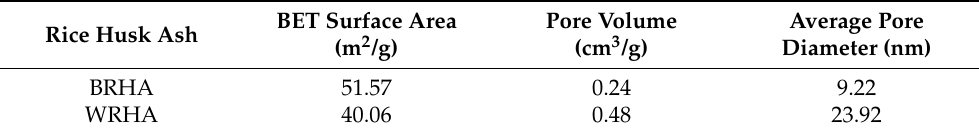
Figure 4. Pore size distributions of BRHA (●) and WRHA ( ○ ). Table 2. The surface area, pore volume and average pore diameter of BRHA and WRHA.